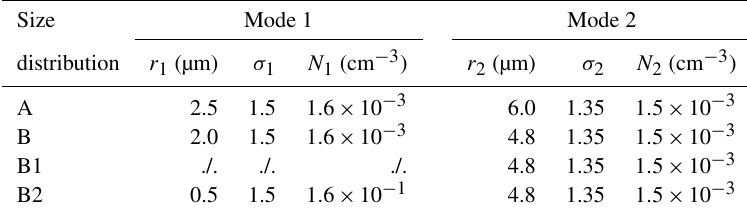
Table 2. Particle size distributions used in radiative transfer scenarios.